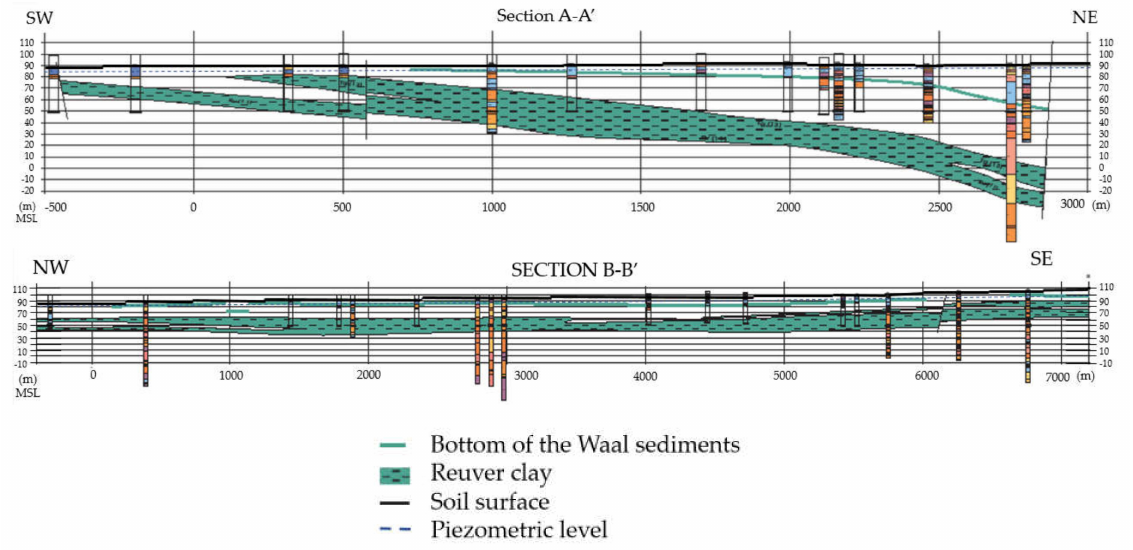
Figure 2. Cross-sections A-A’ and B-B’ of the aquifer presented in Figure